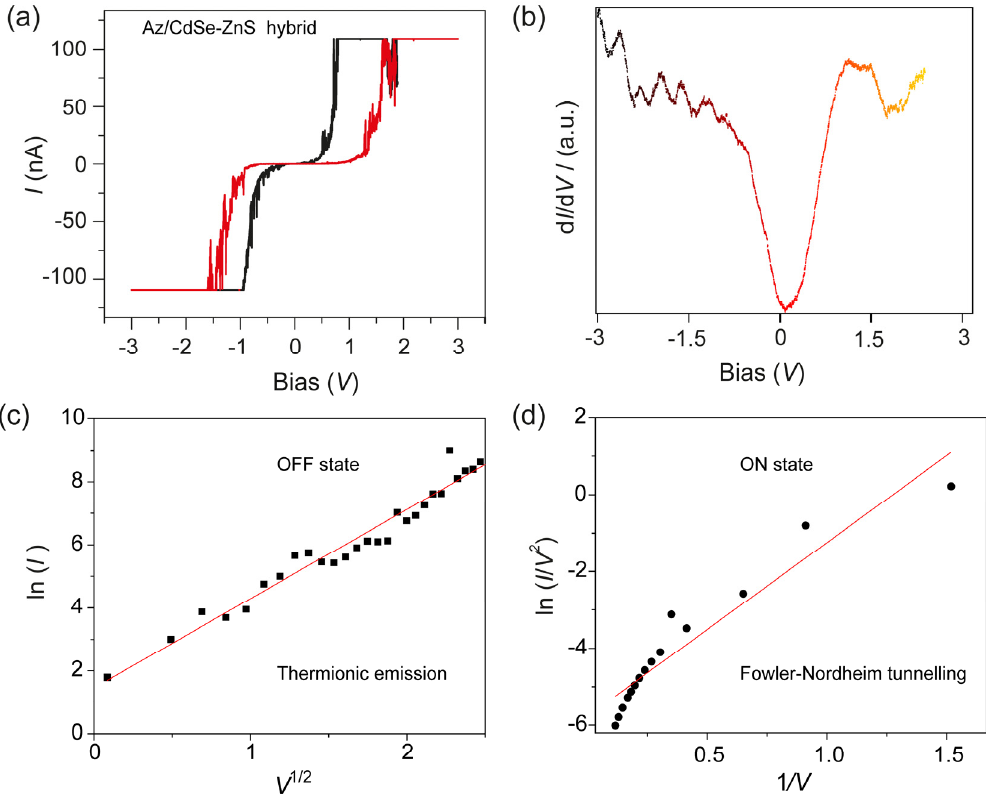
Figure 5 . ( a ) I–V characteristics of the azurin/CdSe-ZnS hybrid on Au, shows low (OFF state) to high (ON state) for memory device applications; ( b ) d I /d V vs V spectra on the azurin/CdSe-ZnS on the Au electrode; ( c ) Plot of ln( I )– V 1/2 fit for the low conducting state, and; ( d ) ln( I / V 2 )–1/ V fit for the high conducting state.